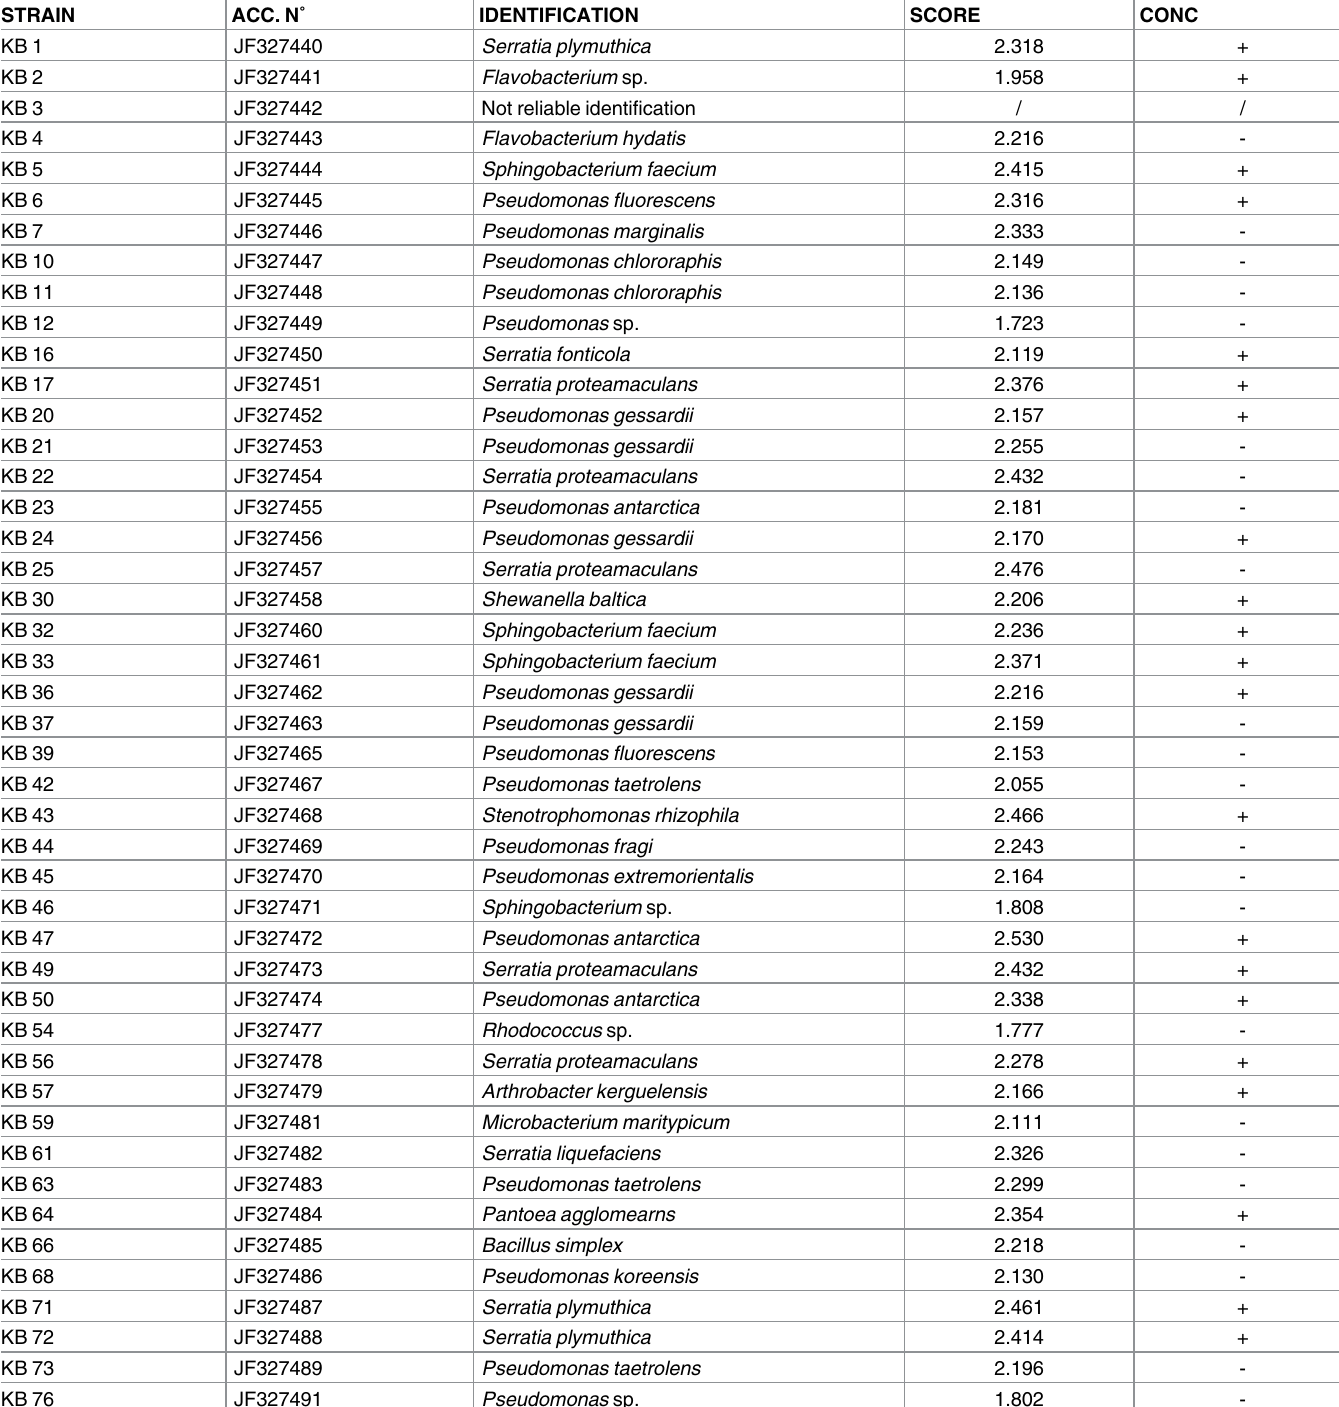
Table 1. KB strains attributions obtained by MB and concordance (at the species level) with the 16S rDNA analysis. STRAIN ACC.